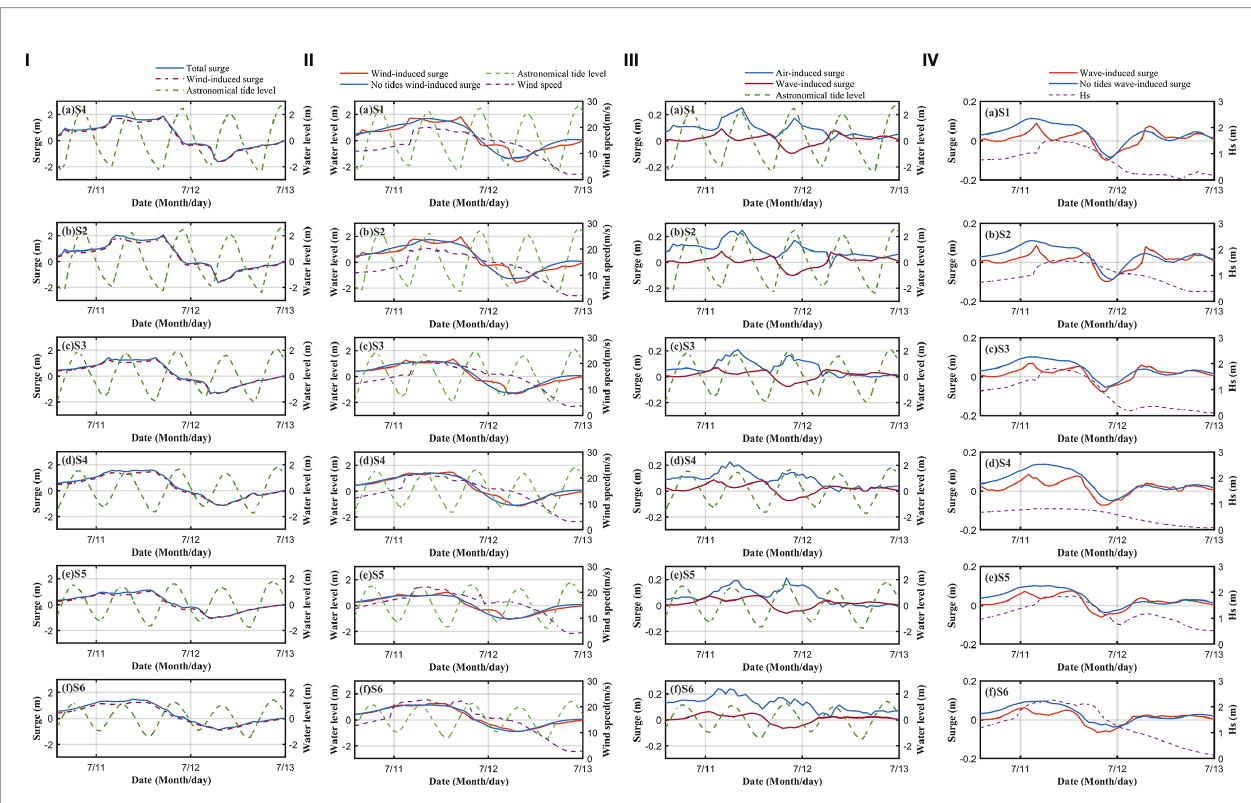
FIGURE 7 | (I) Comparison of wind-induced surge and total surge (July 10-13: green dotted line is astronomical tide level, blue solid line is total surge, red solid line is wind-induced surge). (II) Comparison of wind-induced storm surge with tidal forcing and without tidal forcing (July 10-13). (III) Comparison of pressure-induced, wave-induced and astronomical tide level in July 10-13. (IV) Comparison of wave-induced surge and without tides (July